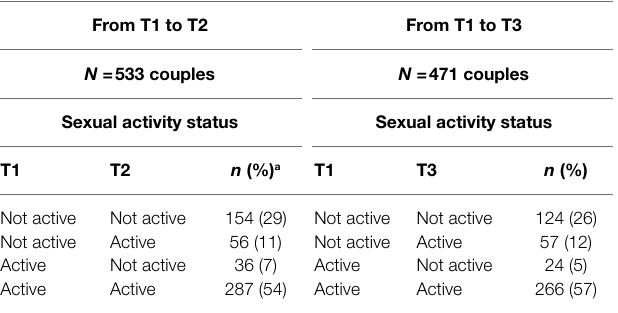
TABLE 2 | Couple sexual activity over time from baseline to T2 and T3, respectively.